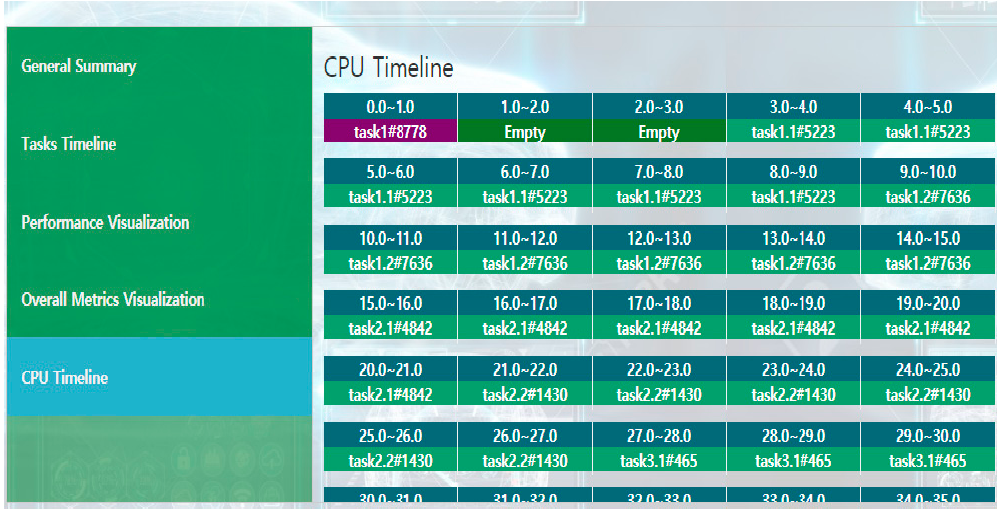
Figure 12. CPU timeline visualization.